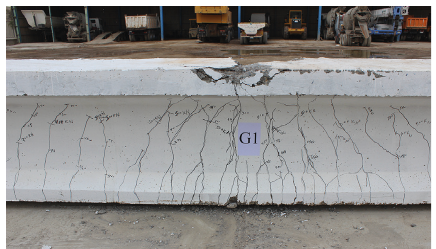
Figure 8: Concrete crushing at midspan of girder G1.